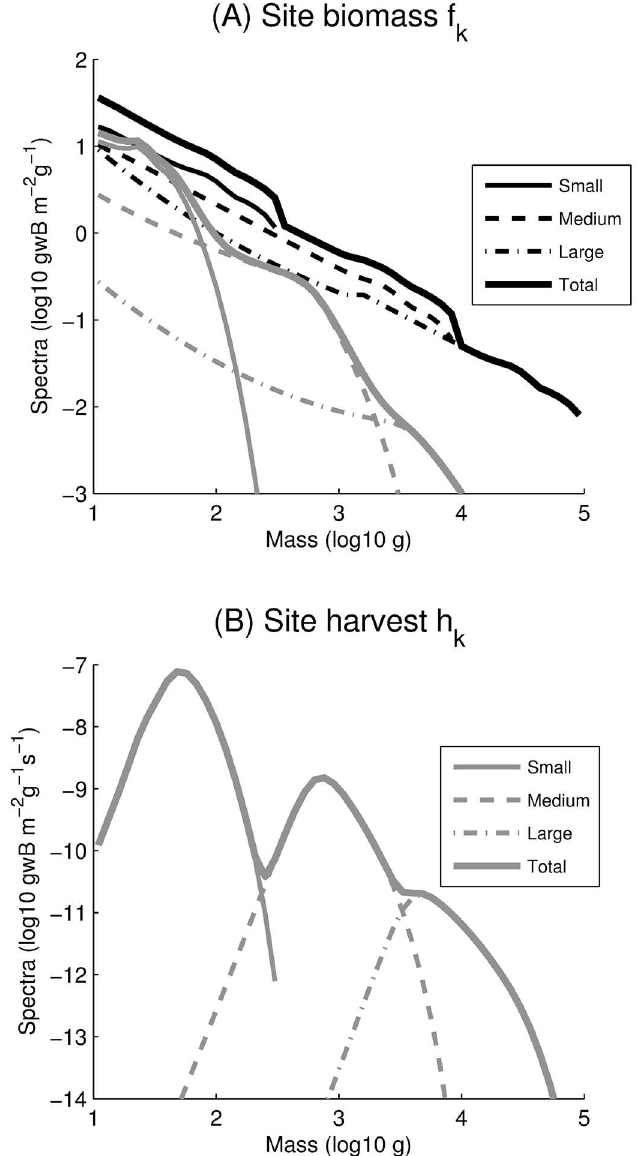
Fig 7. Steady state biomass (A) and harvest (B) size spectra. Black solid, dashed,and dot-dashedcurves representunharvested small, medium,and large groups, respectively,whereas grey curves represent harvestedspectra. Thick curves represent total biomass and harvest spectra. Curves are equilibrium solutionsof simulations for a site in the East Bering Sea LME (64˚N, 165˚W) forced with annualaveragenet primary productionand temperature using a timestep of 15